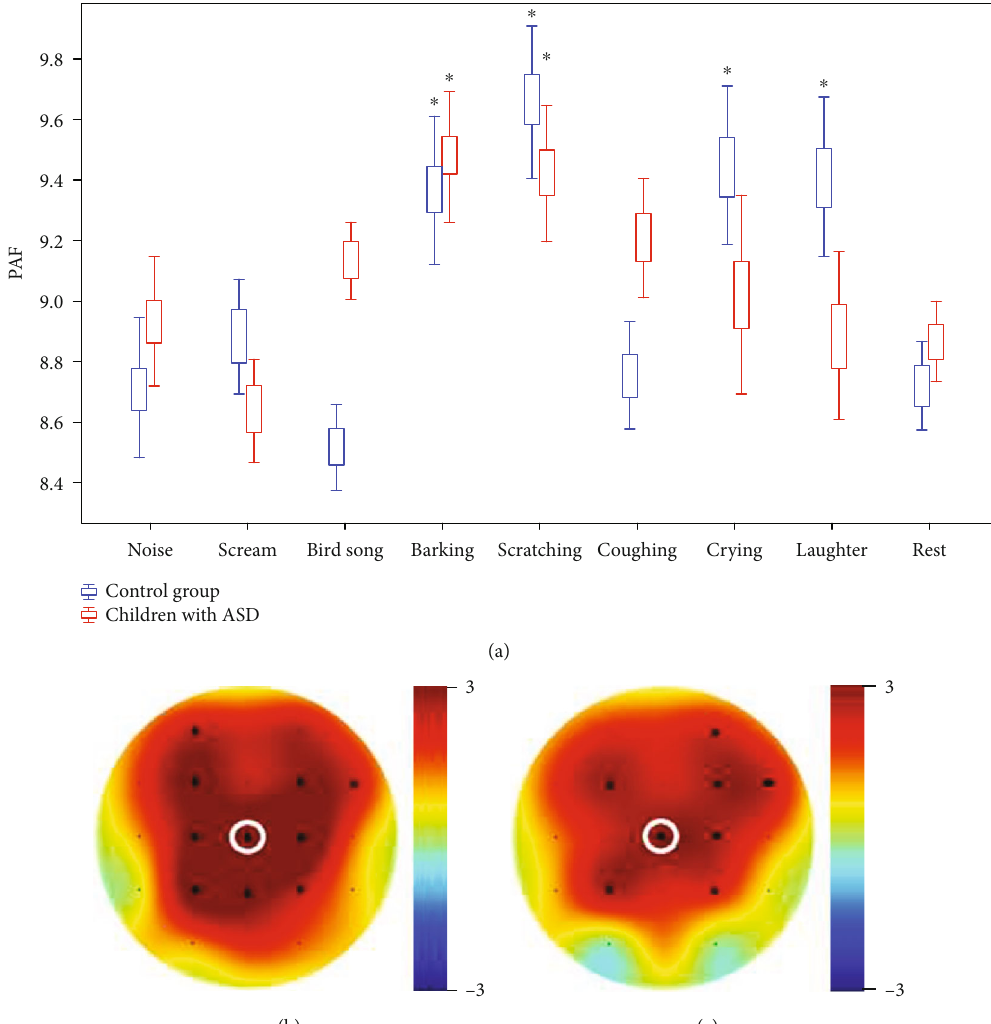
Figure 2: (a) Plots of PAF when listening to stimuli and rest. ∗ Signi fi cant di ff erences between stimuli. x (abscissa): the types of stimuli presented to participants; y (ordinate): PAF averaged for participants of each group. (b, c) The topography was depicted for sound “ barking ” averaged for all participants separately for each group ((b) control group, (c) children with ASD). White circle: Cz — electrode in which PAF values were